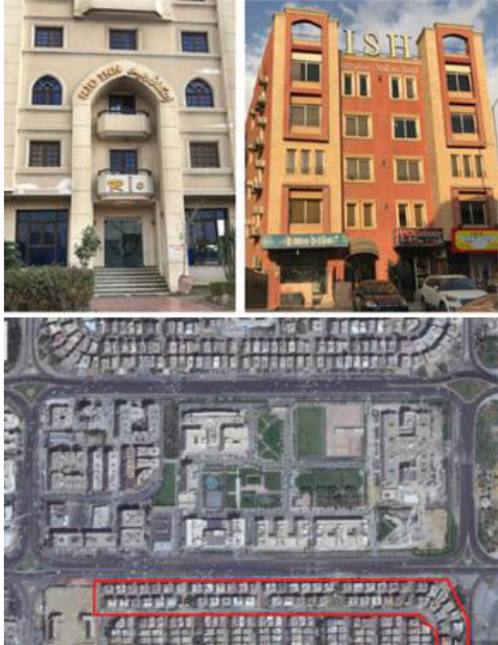
Figure 4. Rental housing samples up and rental housing buildings